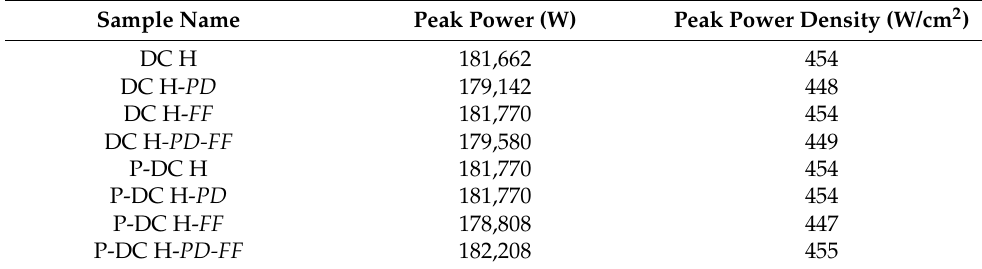
Table 2. Peak power and peak power density of TiN film under various HiPIMS and bias power